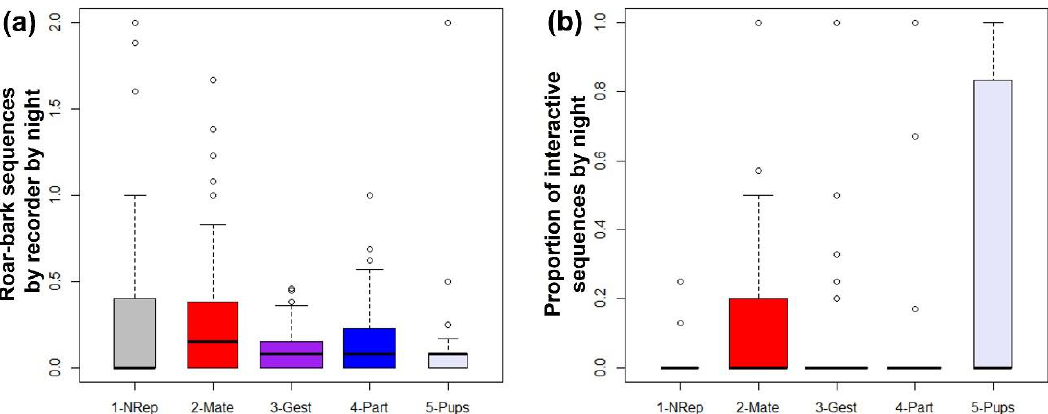
Figure 7. ( a ) Number of maned wolf roar-bark sequences by recorder by night; and ( b ) Proportion of interactive sequences by night during each time period. Time periods are as follows: NRep = non- reproductive; Mate = mating; Gest = gestation; Part = parturition; and Pups = initial parental care. Boxes’ widths are proportional to the number of nights sampled.